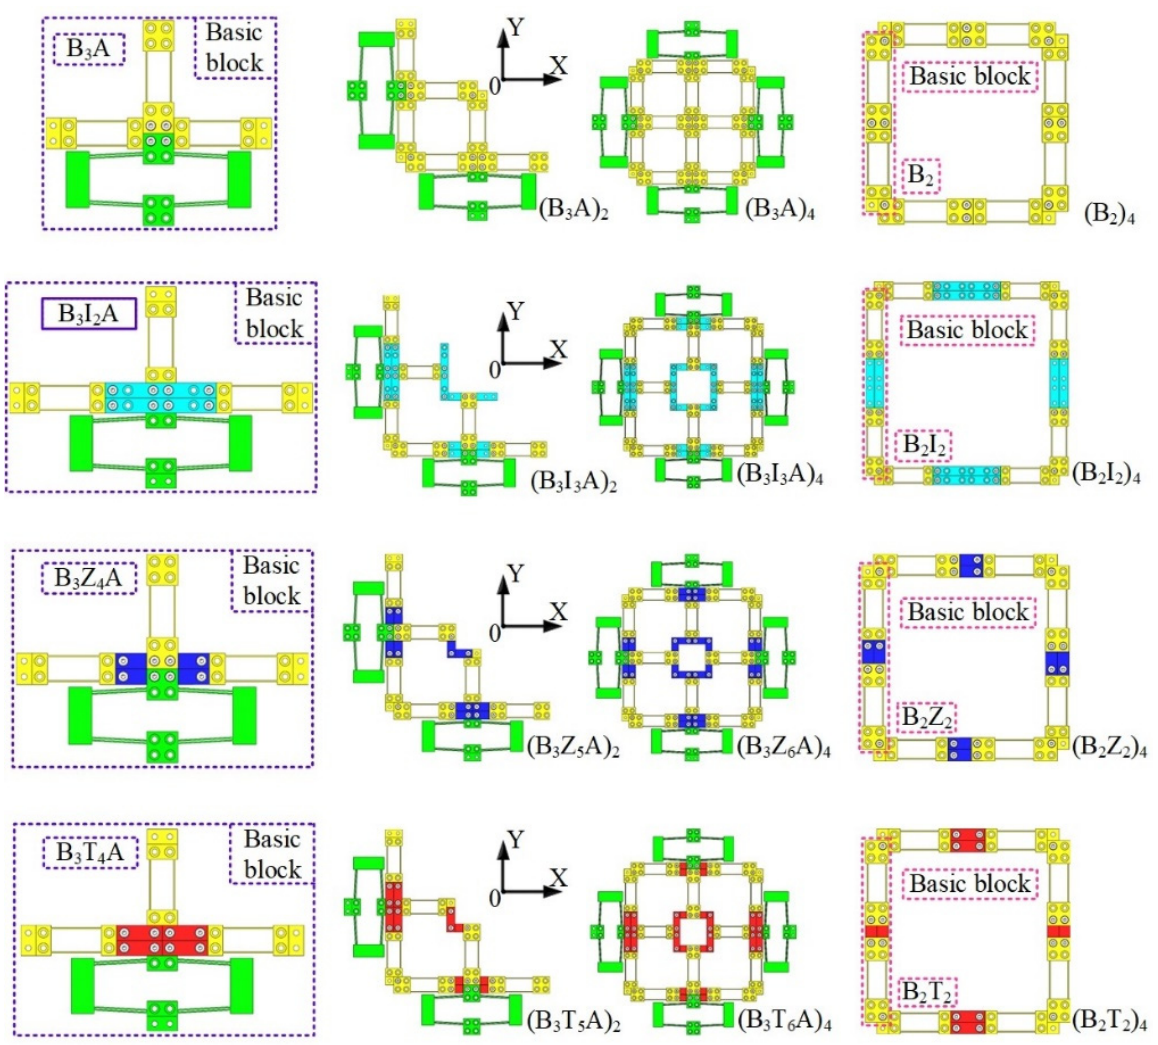
Figure 9. Assembly of two-DOF MPSs based on basic blocks.